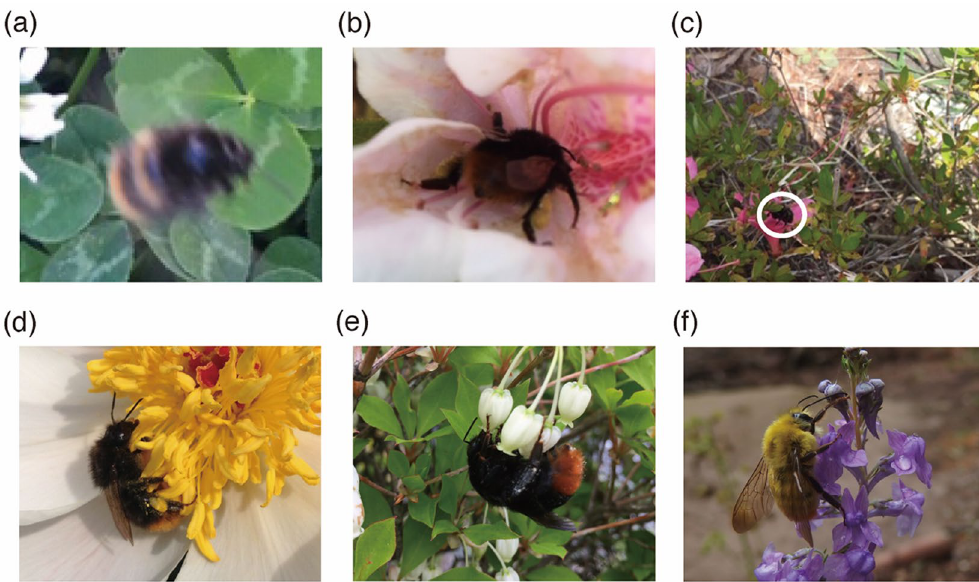
Figure 1. Difficulties of species identification of bees in photographs taken by citizens. Uppers represent low quality photographs. ( a ) Out of focus, ( b ) partially invisible, and ( c ) hard to see by shadow (a bumble bee appears within a white circle). Lowers represent interspecific similarity and intraspecific variation of bees. ( d ) Female Bombus ardens ardens , ( e ) female B. ignitus , and ( f ) male B. ardens